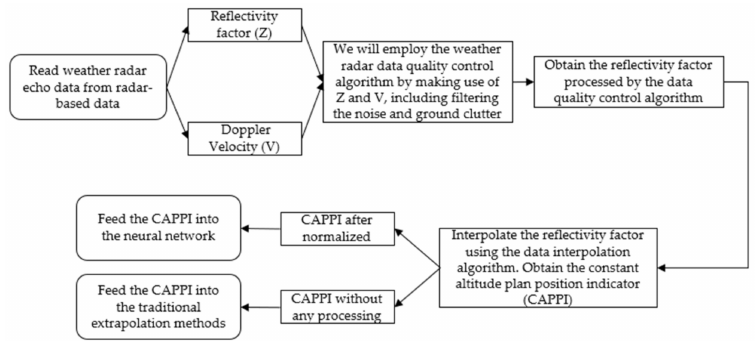
Figure 1. Flowchart of data